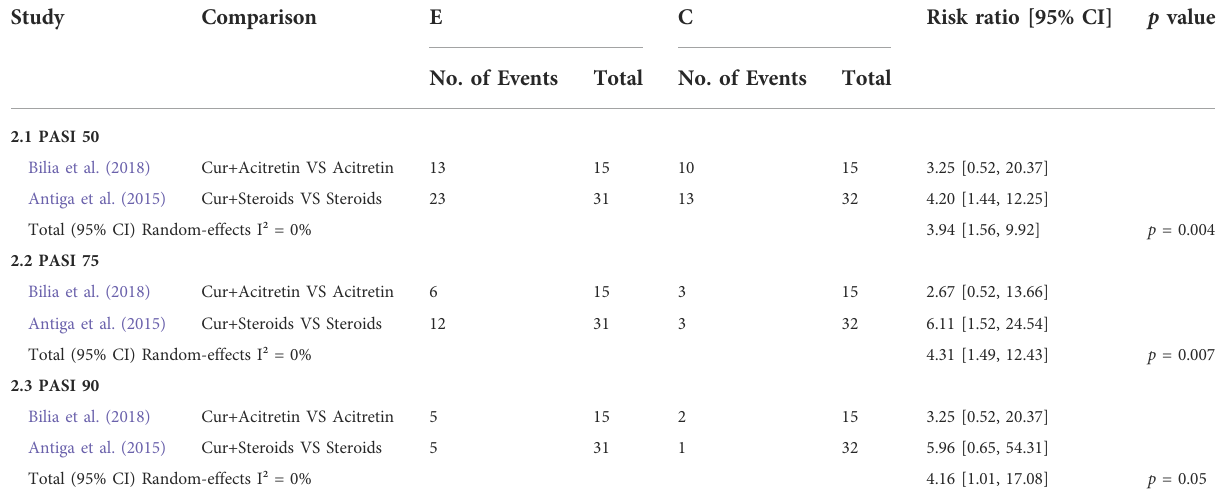
TABLE 2 Subgroup analysis of PASI 50, PASI 75, PASI 90 in clinical